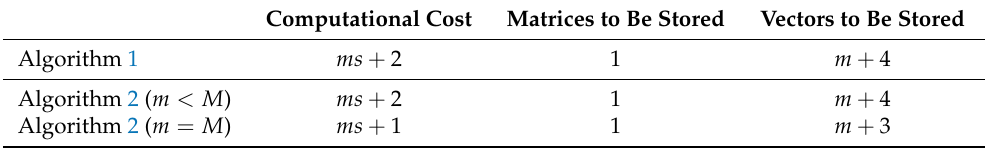
Table 1. Computational and storage costs for Algorithms 1 and